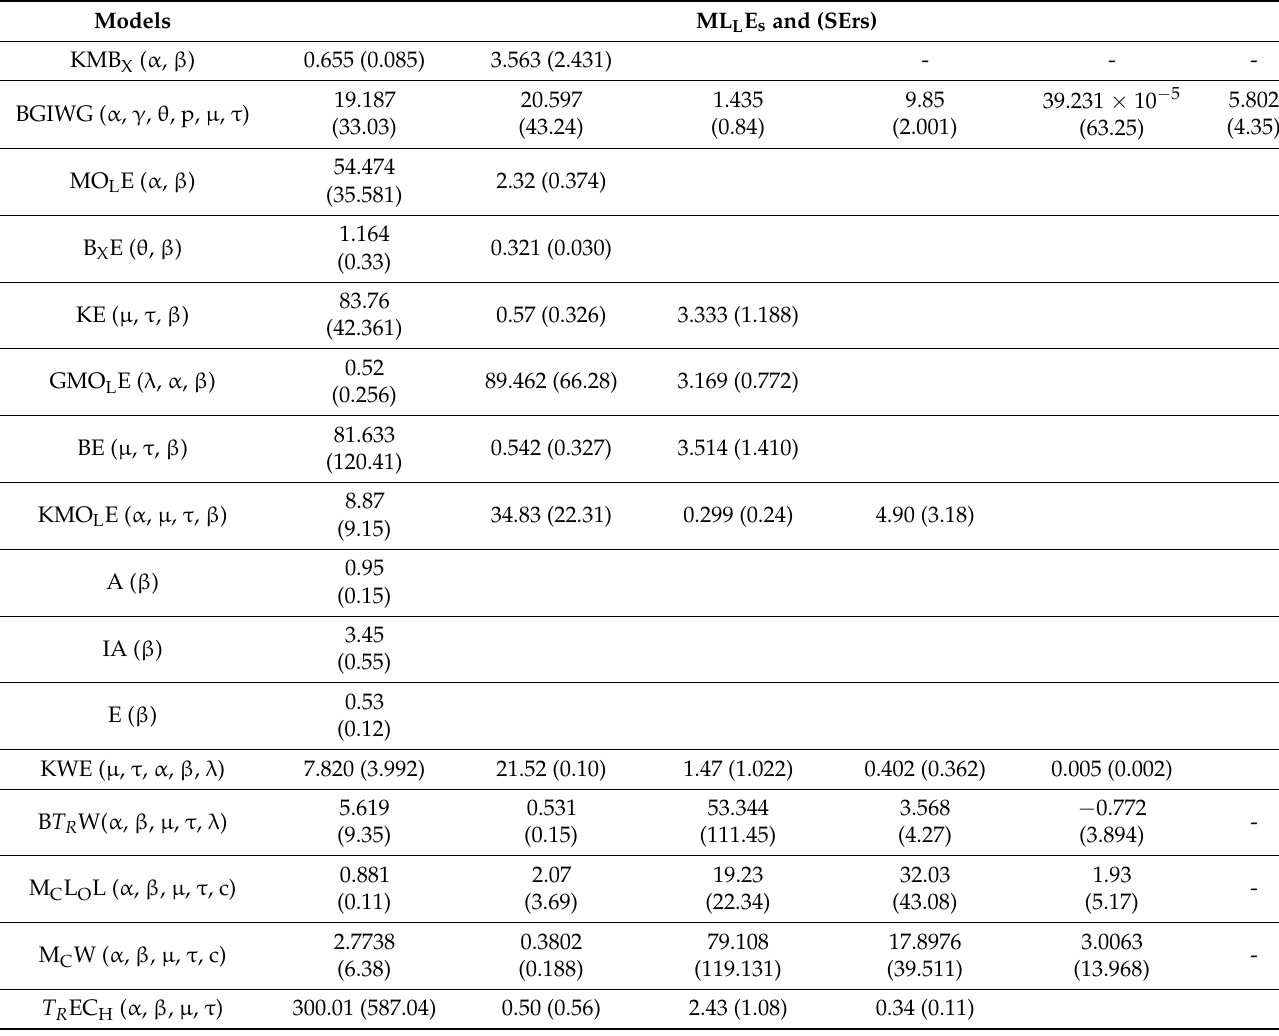
Table 9. Numerical values of ML L E s and (SErs) for the second data